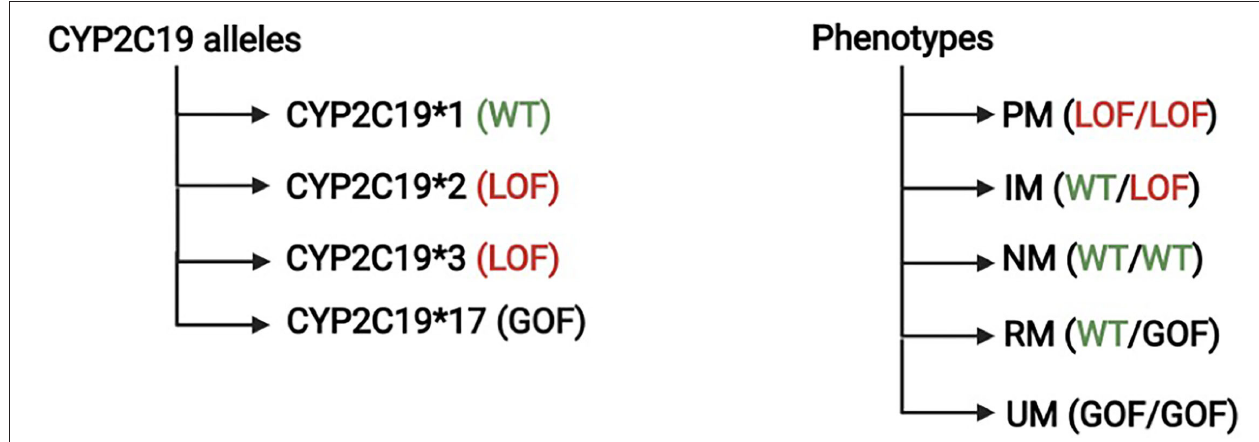
FIGURE 2 | Cytochrome P450 genotypes and phenotypes. The Clinical Pharmacogenetics Implementation Consortium categorized the level of CYP2C19 function into five different phenotypes; poor metabolizers (PM), intermediate metabolizers (IM), normal metabolizers (NM), rapid metabolizers (RM), and ultrarapid metabolizers